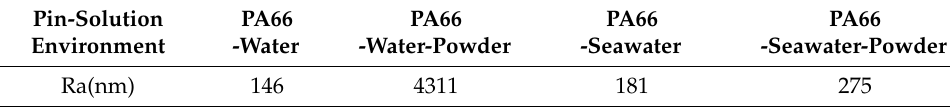
Figure 11. SEM images of PA66 pins.